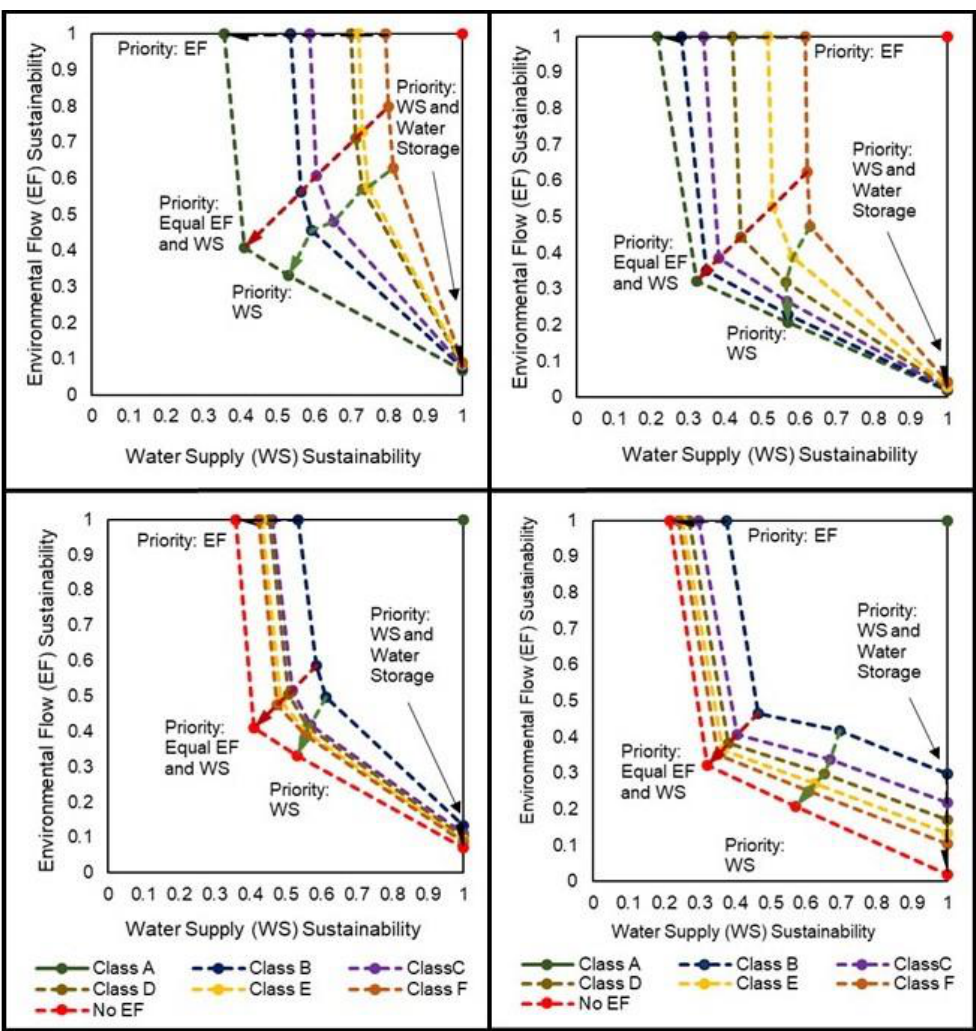
Figure 6. Variation of WS Sustainability and EF Sustainability for Malwatu Oya ( left ) and Kalu Ganga ( right ) basins when gradually increasing levels of EF are released ( top ) and gradually increasing levels of yields are withdrawn ( bottom ) from a reservoir with a storage capacity of 1.0 MAR units, with different priorities assigned to water supply, environmental flow provision, and water storage.